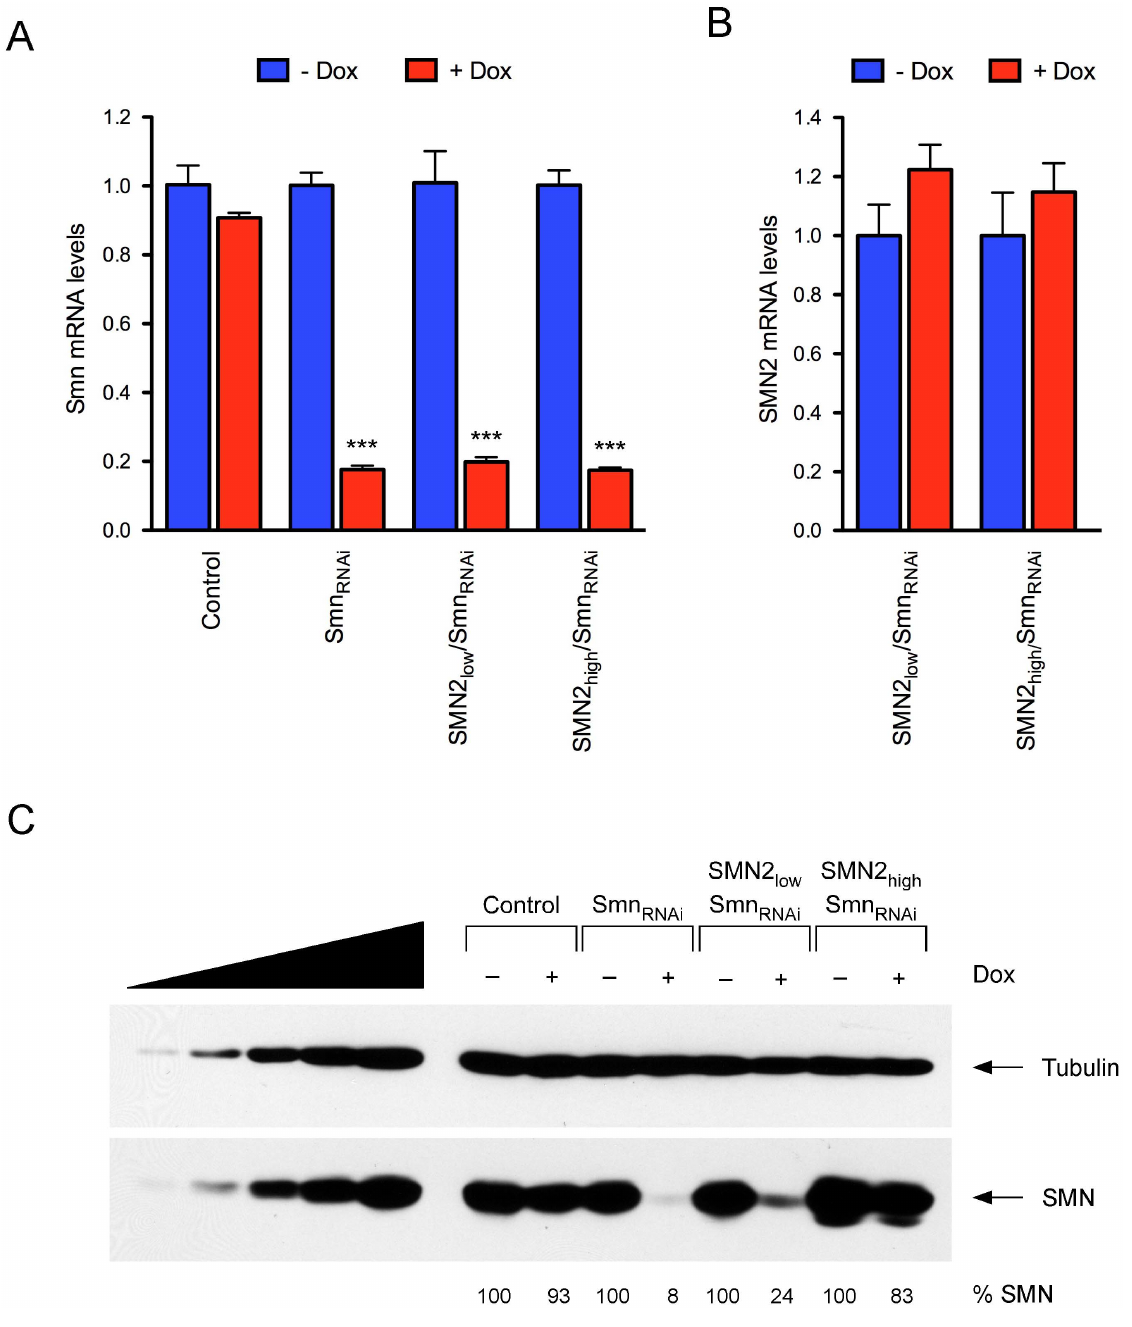
Figure 4. Inducible knockdown of endogenous mouse Smn in NIH3T3-SMN2/Smn RNAi cell lines. (A) RT-qPCR analysis of mouse Smn mRNA levels in wild-type (Control), NIH3T3-Smn RNAi , NIH3T3-SMN2 low /Smn RNAi and NIH3T3-SMN2 high /Smn RNAi cell lines cultured with and without Dox for 7 days. Data in Dox-treated cells were normalized to those in untreated cells and represented as mean and SEM (n=3; ***=p , 0.001; t-test). (B) RT-qPCR analysis of human SMN2 mRNA levels in NIH3T3-SMN2 low /Smn RNAi and NIH3T3-SMN2 high /Smn RNAi cell lines cultured with and without Dox for 7 days. Data in Dox-treated cells were normalized to those in untreated cells and represented as mean and SEM. (C) Western blot analysis of equal amounts of proteins from wild-type (Control), NIH3T3-Smn RNAi , NIH3T3-SMN2 low /Smn RNAi and NIH3T3-SMN2 high /Smn RNAi cell lines cultured with and without Dox for 7 days using monoclonal antibodies against the indicated proteins. For each cell line, SMN levels in Dox-treated relative to untreated cells are shown at the bottom. doi:10.1371/journal.pone.0071965.g004 revealed a similar time-dependent increase in the number of (Figure 6C-D). Consistent with the growth arrest phenotype at the untreated NIH3T3-Smn RNAi and NIH3T3-SMN2 low /Smn RNAi time of plating, the number of doxycycline-treated NIH3T3- cells with normal levels of SMN and the time zero analysis Smn RNAi cells did not change over time (Figure 6C). In contrast, confirmed the presence of equal numbers of cells at plating doxycycline-treated NIH3T3-SMN2 low /Smn RNAi showed a mod-